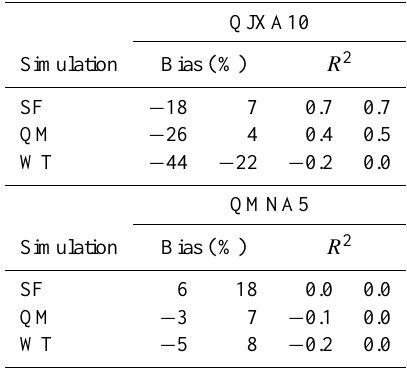
Fig. 10: Difference between the QJXA10 calculated with the two simulations forced by downscaling methods and the simulation forced by SAFRAN/F (in %) for the period 1970–1999. Table 3. Comparison between the simulations and the observations. The columns with normal font correspond to the stations that the model simulates reasonably well (NSE > 0.5). The columns in italic correspond to the stations with a poor NSE (NSE <